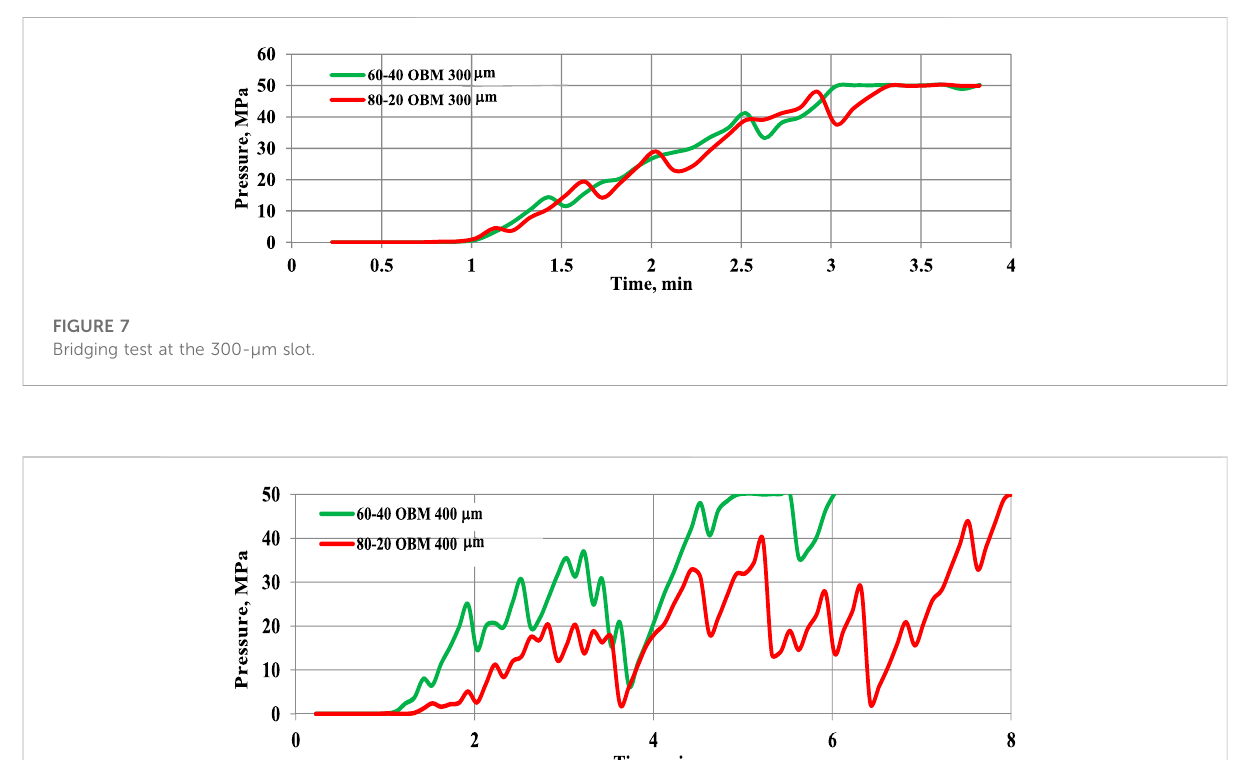
FIGURE 8 Bridging test at the 400- μ m slot.